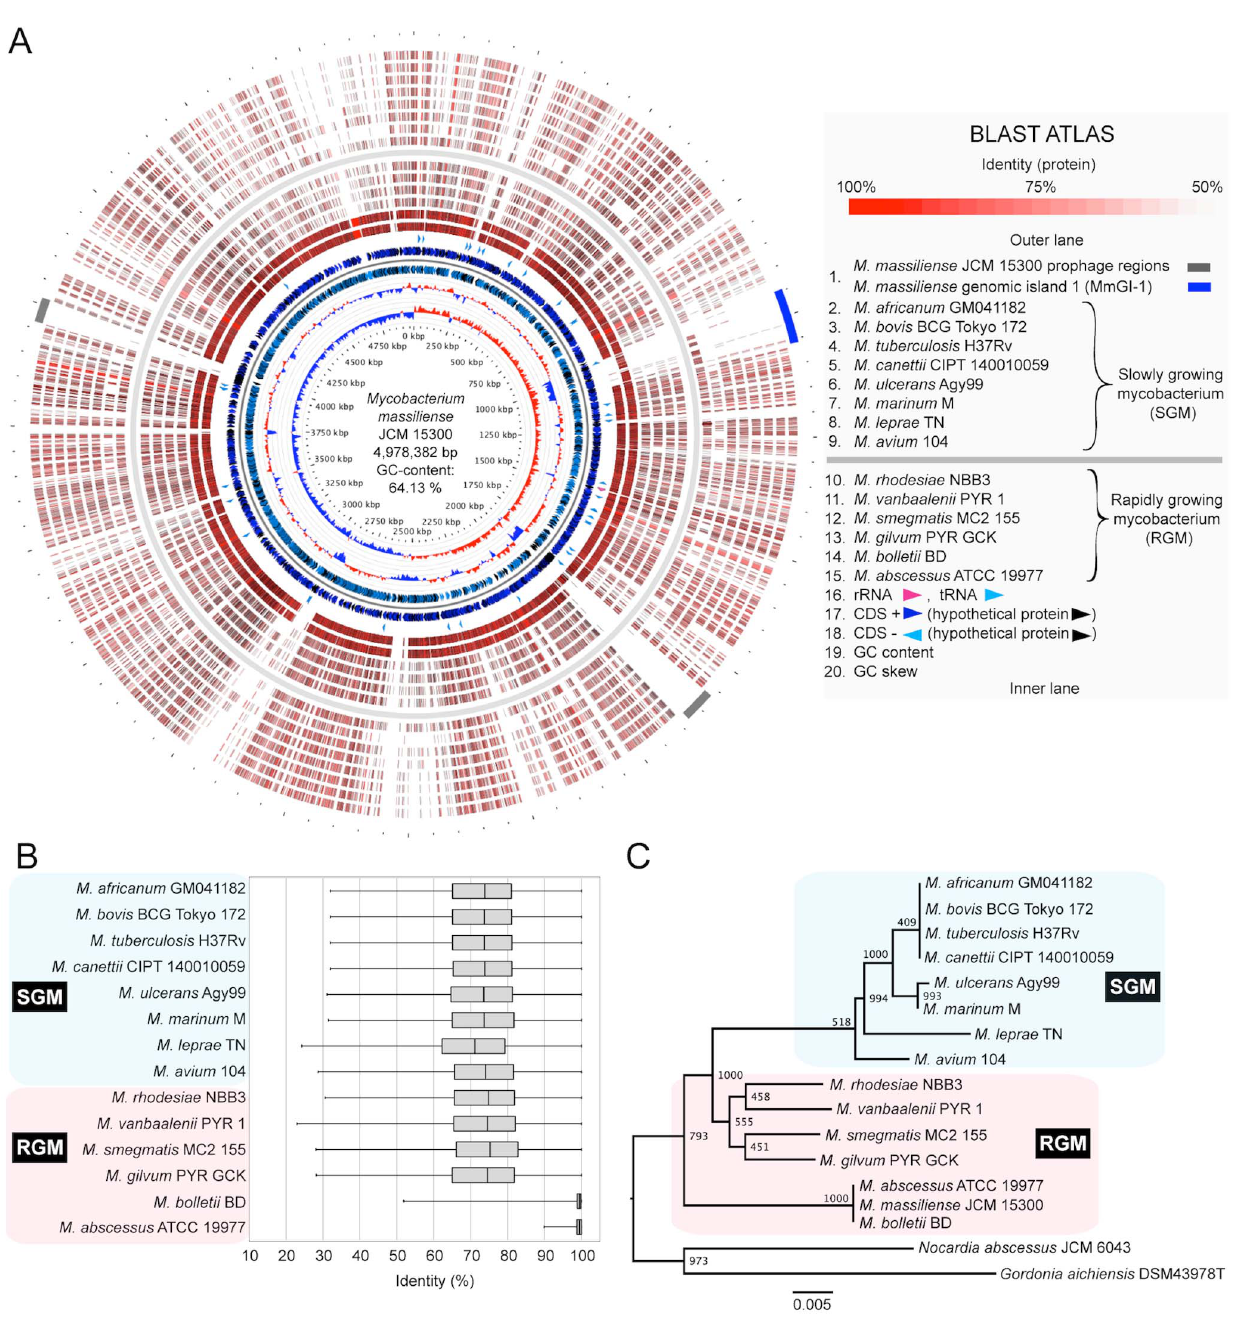
Fig. 1. Circular representation of the M. massiliense JCM 15300 genome and comparative analysis among the complete genomes of Mycobacterium species. A. BLAST atlas of M. massiliense JCM 15300. The coding region of strain JCM 15300 was aligned against those of 14 other Mycobacterium genomes using BLASTP. The results are displayed as colored circles with increasing color intensity signifying increased similarity. It was estimated that the number of conserved proteins was 1,516 among all 14 Mycobacterium genomes. B. Box plot of identity percentage of conserved proteins between M. massiliense JCM 15300 and 14 other Mycobacterium spp. The top of each box in the box plot indicates the 75th percentile, the bottom of each box indicates the 25th percentile and the center bar represents the median. C. Neighbor-joining phylogenetic tree based on 16S rRNA gene sequencing of Mycobacterium with 1,000-fold bootstrapping. Scale bar indicates number of substitutions per site. The number at each branch node represents the bootstrapping value. Nocardia abscessus JCM 6043 (GenBank: AF430018) and Gordonia aichiensis DSM43978T (X80633) were used as outgroups.